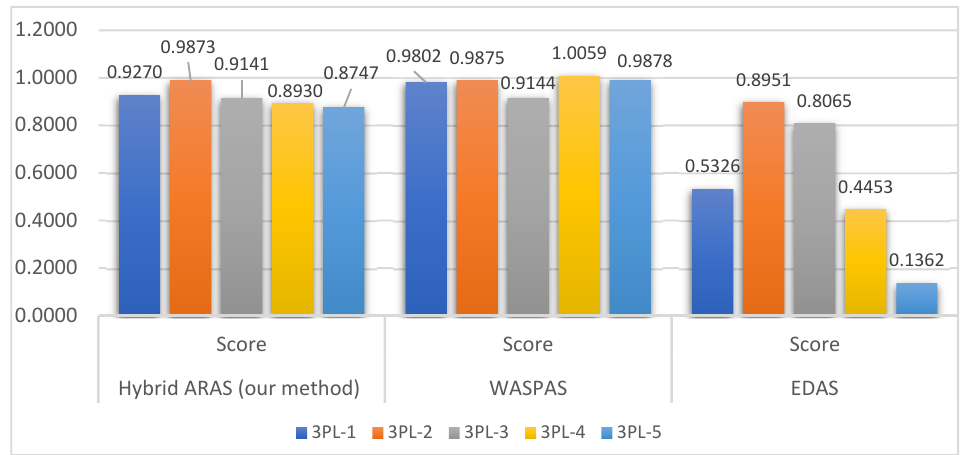
Figure 5. The comparative analysis of the hybrid–ARAS approach with WASPAS and EDAS.